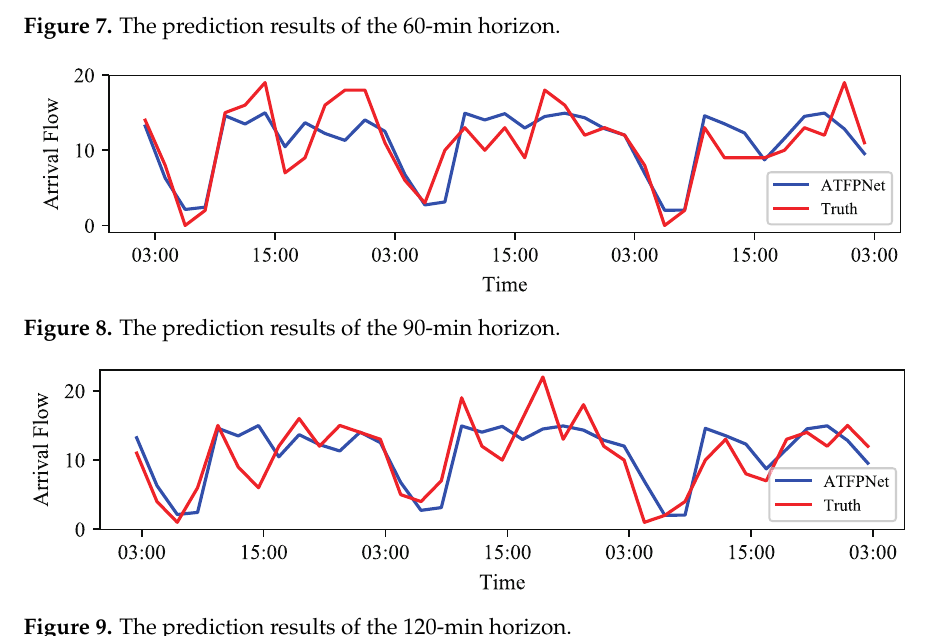
Figure 9. The prediction results of the 120-min